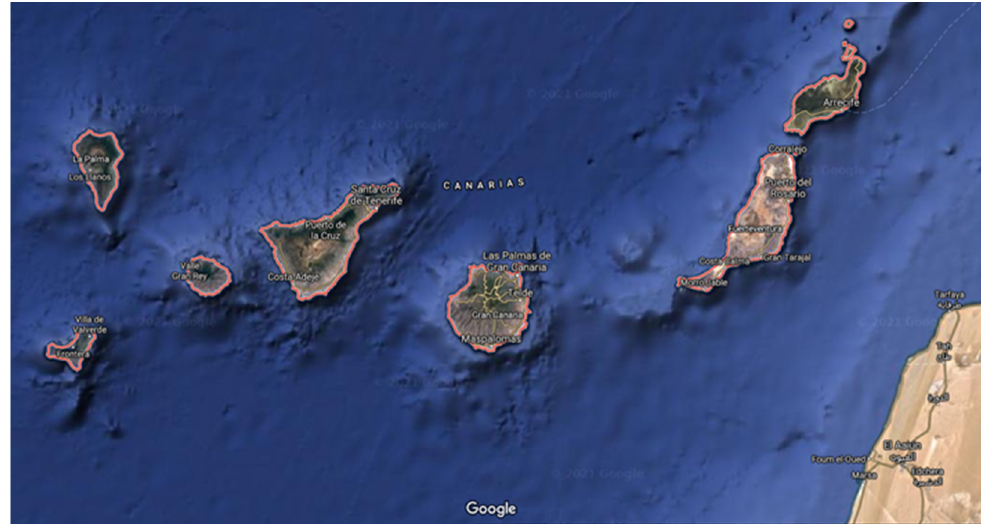
Figure 1. Canary Islands (Source: Google Maps™).